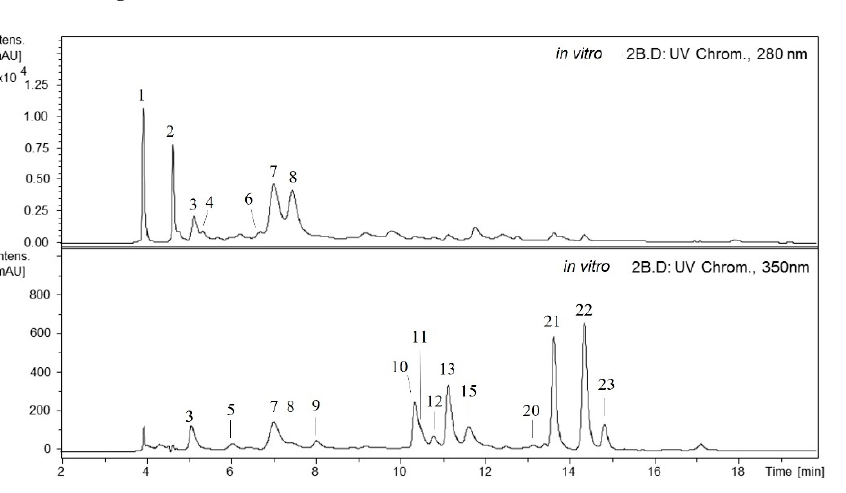
Figure 1. HPLC ‐ DAD ‐ ESI (Ion Trap) ‐ MS n (280, 350 nm) phenolic profile of methanolic extract from in vitro leaves of A. chilensis . Identity of compounds is shown in Tables 1 and 2.